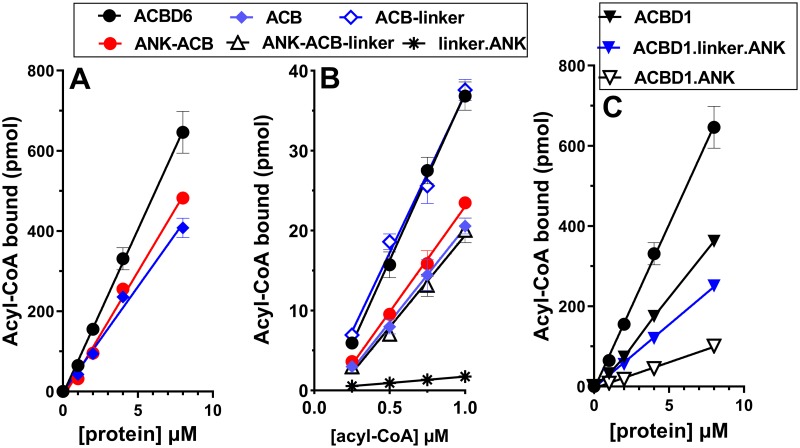
Analysis of module deletion and switch on acyl-CoA binding function.Binding assays were performed with 15μM 14C-C18:1-CoA and increasing concentrations of the indicated proteins (0 to 8μM) (Panel A and C) and with 2μM of the indicated proteins with increasing concentrations of 14C-C18:1-CoA (0.25 to 1μM) (Panel B). Error bars represent the standard deviations of values obtained from four measurements.